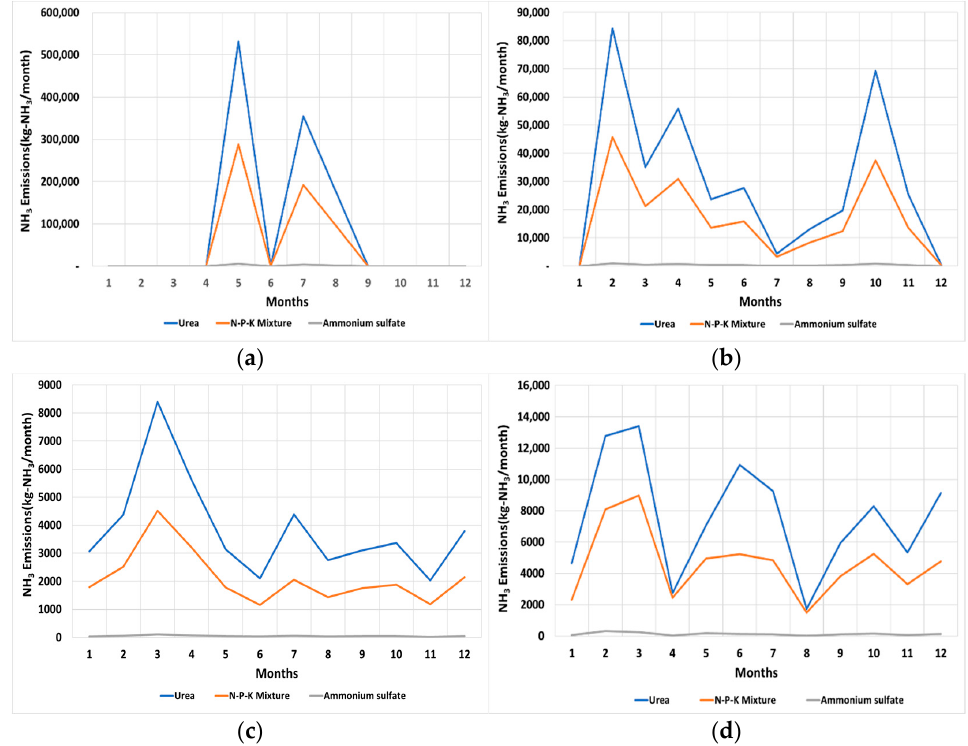
Figure 5. NH3 emissions by farmland in Jeolla-do (2017) with Method II. ( a ) Rice paddies; ( b ) fields; ( c ) greenhouses; ( d ) pomiculture.